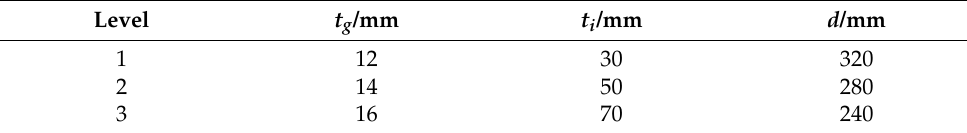
Table 2. Factors and levels for the orthogonal